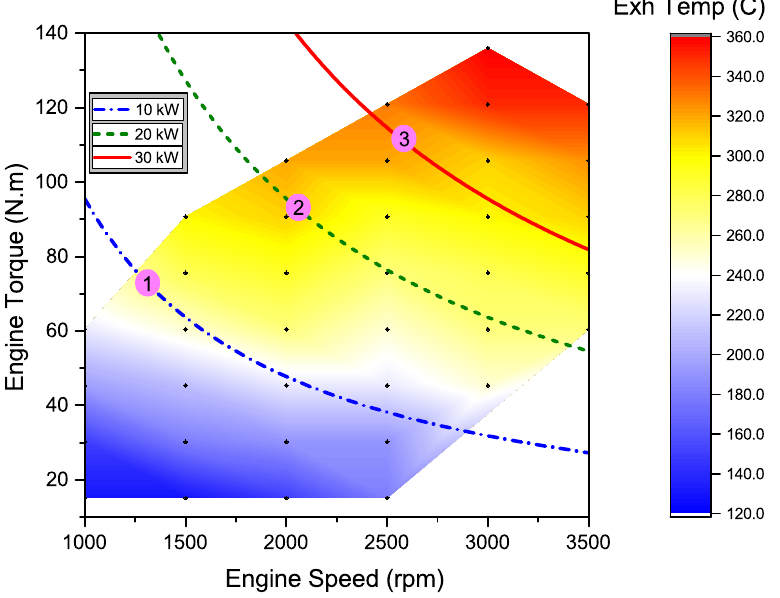
Figure 6. RCCI exhaust gas temperature map for selecting the RCCI engine operating points. The data from [40] was used to generate this figure.